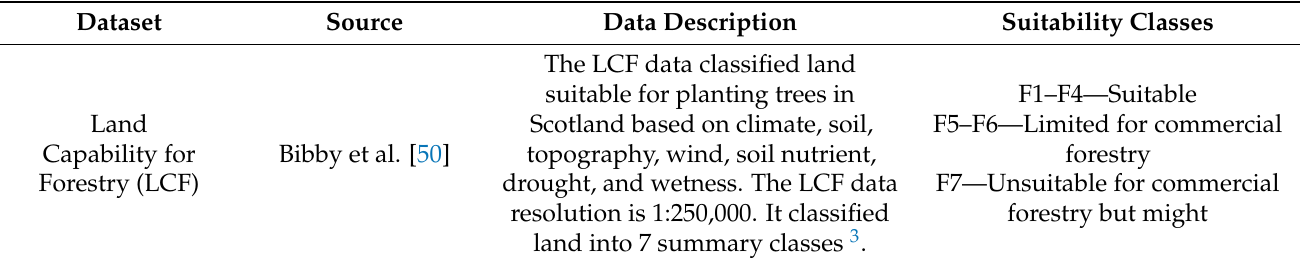
Table 3. Description of the LCF classification [50].